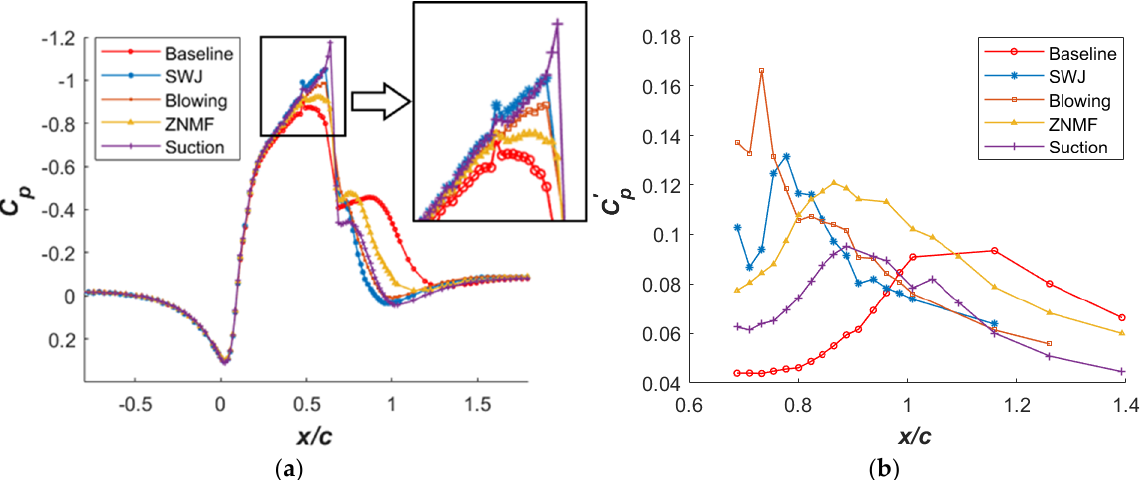
Figure 12. Comparison of different AFC methods for C µ = 0.24%: ( a ) centerline pressure distribution; ( b ) fluctuating pressure distributions.